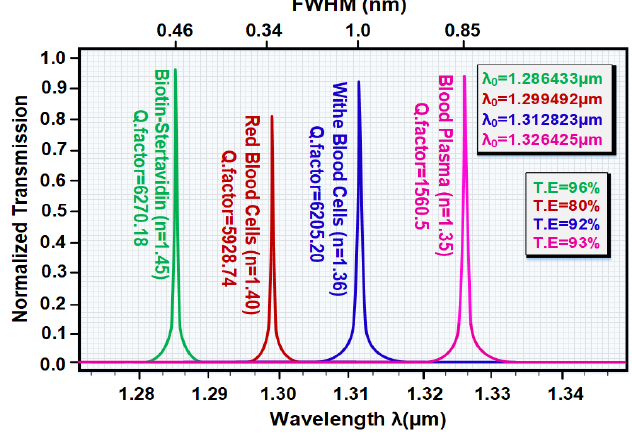
Figure 3. Show the resonance wave lengths of different elements of blood. Here, the amount of glucose concentration would be determined in human urine. As seen in the table, the refractive index of the urine ranges from 1.332 to 1.340. The first-time urine prototype shows an average refractive index in the range 0.0019 ± 1.336 as well as the random samples 0.0017 ± 1.335. Moreover, the urine refractive index has shown high sensitivity to the changes in its concentration of glucose. A very high refractive index would be observed in a diabetic person [53]. The normal glucose level in normal persons ranges between 0 and 15 mg/dL. Table 2 reports the refractive index values for greater glucose concentration, respectively. Table 2. The amount of glucose concentrations in human urine for sick and normal people. Urine Sample with Glucose Concentration